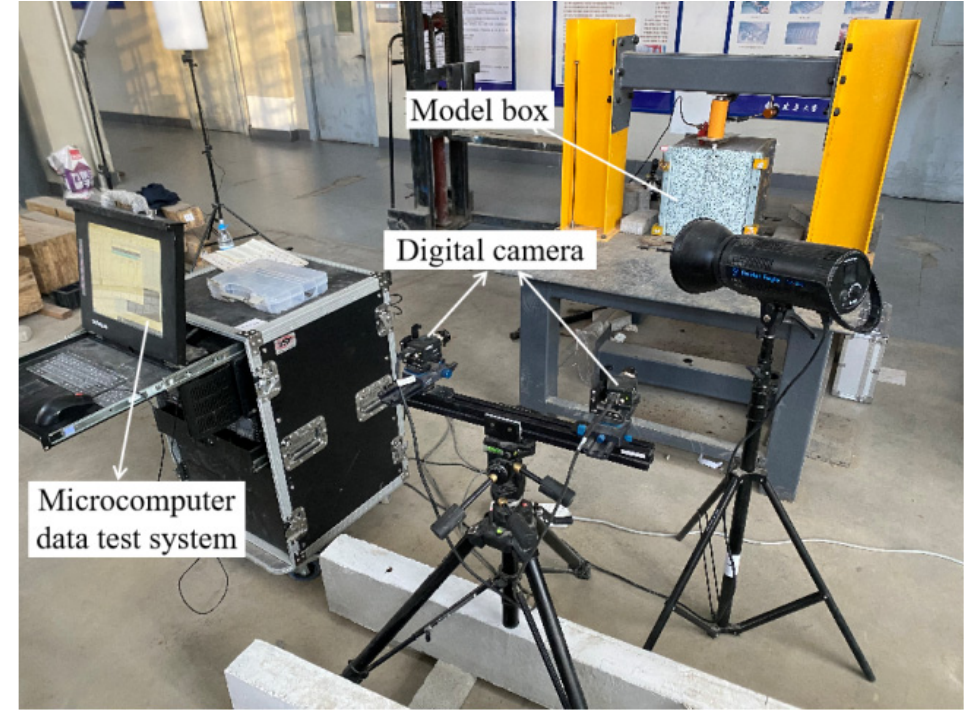
Figure 4. Test instrument.